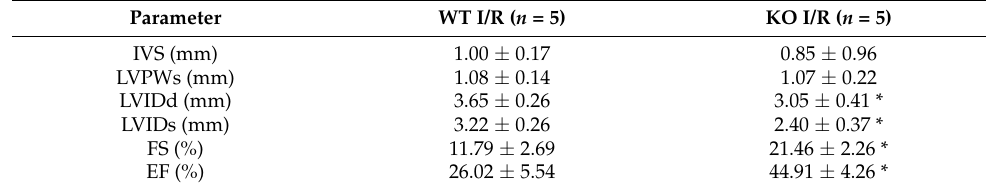
Table 2. Echocardiographic measurements for iPLA 2 β -KO and WT mice at 24 hours after I/R operation.